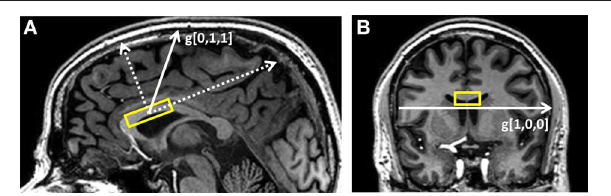
FIGURE 1 | Typical placement of the DWS VOI (A) on the sagittal plane and (B) on the coronal plane. The gradient directions used in the experiment are g [0,1,1], which is mostly perpendicular to the callosal fibers, and g [1,0,0], which is mostly parallel to